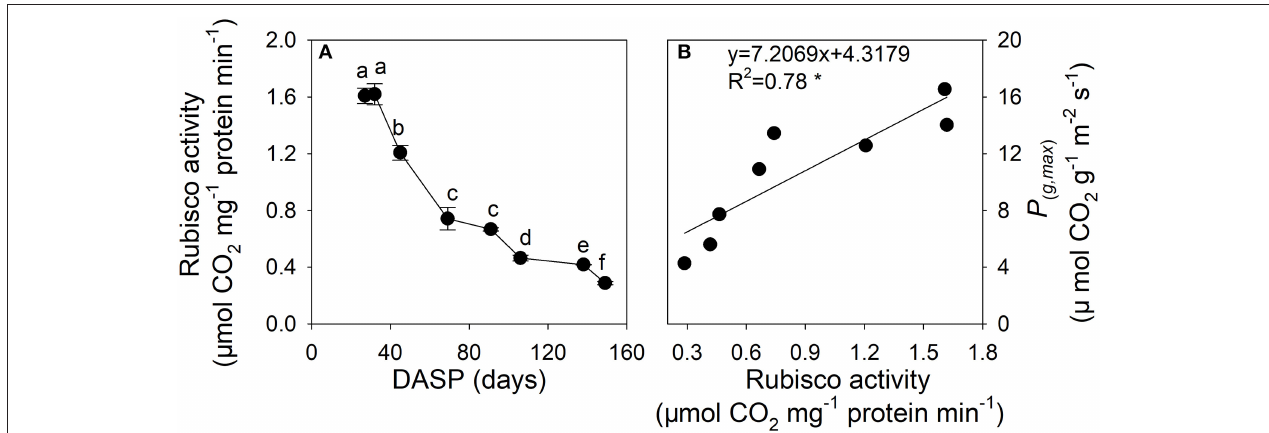
FIGURE 6 | Ribulose-1,5-biphosphate carboxylase (Rubisco) activity (A) and the correlation between the maximal rate of gross photosynthesis at light saturation ( P ( g,max ) ) per area, and Rubisco activity (B) in sarcotesta of seeds of Torreya grandis cv. “Merrillii” during seed development in 2015. In (A) the mean ± SD is indicated. Different letters denote significant differences at P ≤ 0.05 level. n = 4 trees. DASP, days after seed protrusion. The solid line represent the best-fit linear regressions between the maximal rate of gross photosynthesis at light saturation ( P ( g , max ) ) per area, and Rubisco activity: * P ≤ 0.05; ** P ≤ 0.01; *** P ≤ 0.001; ns, not significant.